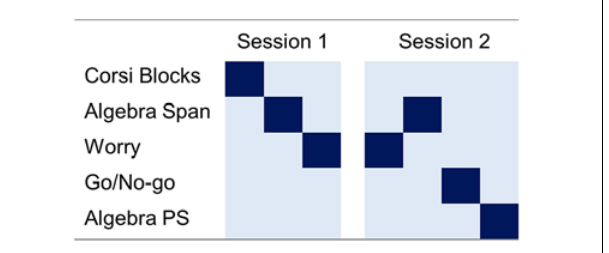
FIGURE 1 | Study design and task sequence for testing sessions one and two. Dark squares indicate task completed.Task sequence is left to right.The figure is schematic, and not representative of time intervals; session one occurred in the morning, and session two in the